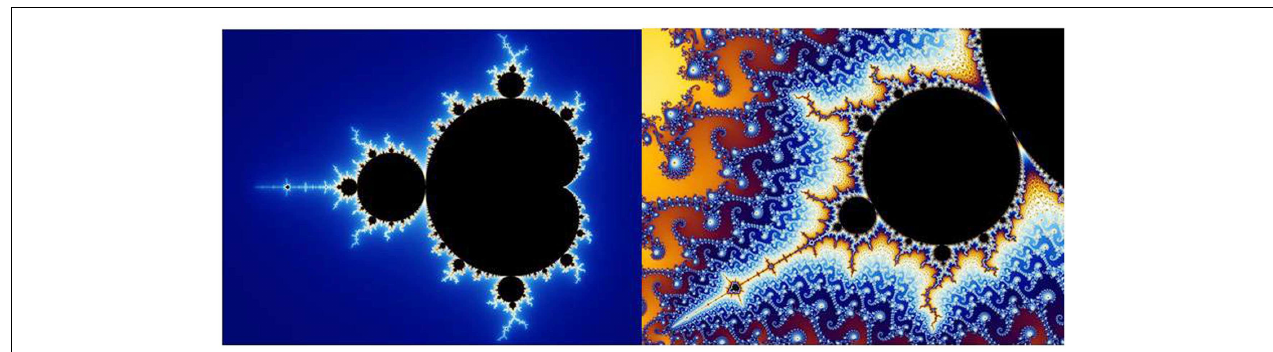
FIGURE 13 | Mandelbrot set low resolution (left) and high resolution (right). Public source: http://en.wikipedia.org/wiki/File:Mandel_zoom _00_mandelbrot_set.jpg